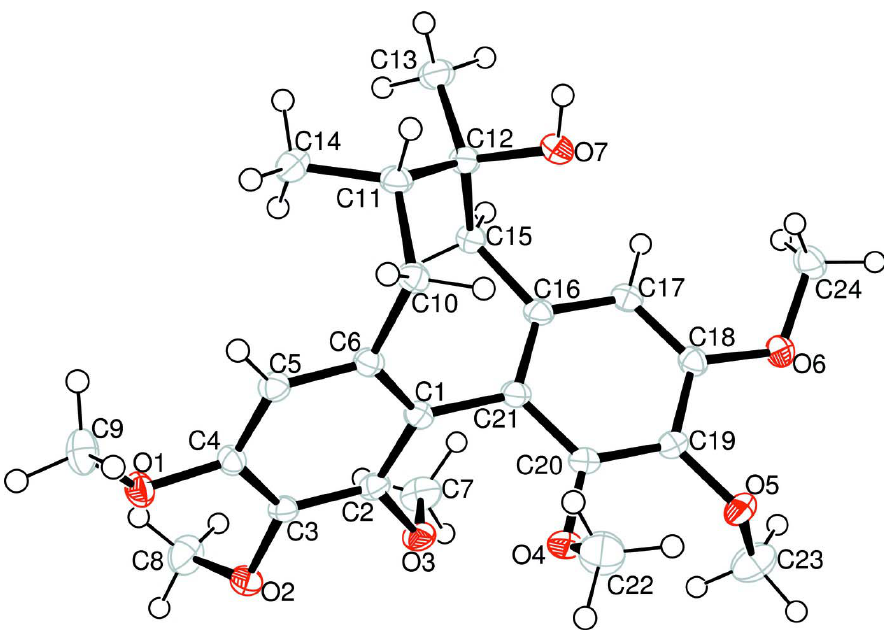
Figure 1 View of the first molecule in the asymmetric unit with the atom-numbering scheme and 50% probability displacement ellipsoids.